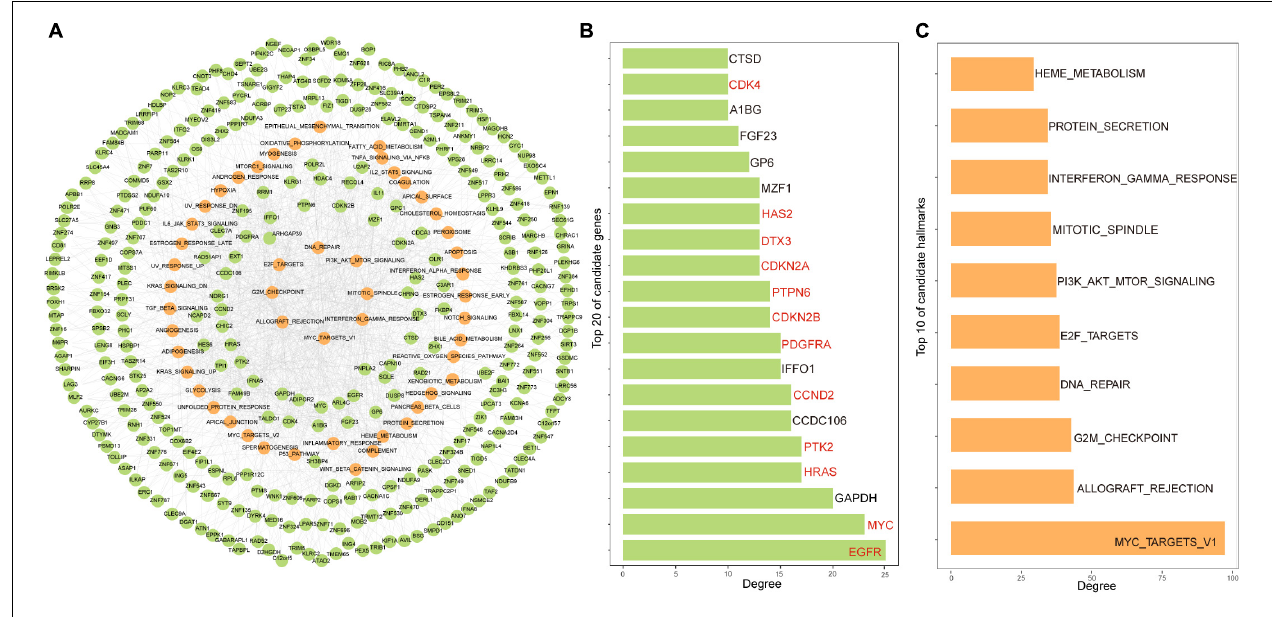
FIGURE 2 | Constructing the candidate gene-hallmark network using random walk for LGG. (A) The candidate gene-hallmark network, the green dots represent candidate genes, and the yellow ones represent hallmarks signature affected by candidate genes; (B) the top 20 genes with a high contribution degree of the candidate gene-hallmark network, the genes marked in red represent known cancer genes; (C) the top 10 hallmarks with a high contribution degree of the candidate gene-hallmark